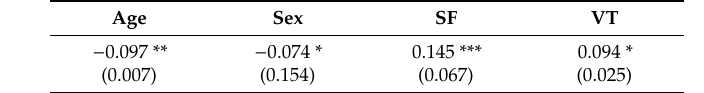
Table 5. Model 3. Dependent variable (planning dimension of an entrepreneurial attitude). Independent variables: age, sex, level of studies, professional activity, and health. Age Sex SF VT − 0.097 ** − 0.074 * 0.145 *** 0.094 * (0.007) (0.154) (0.067) (0.025)